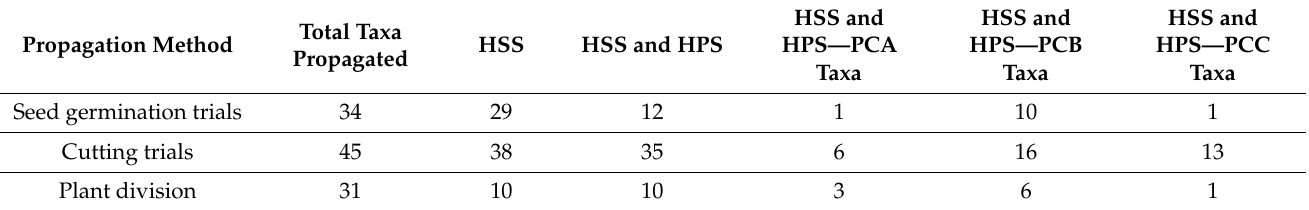
Table 4. Overview of propagation success and survival success per method employed during the ex-situ conservation of priority plants (PPs) of different categories (PCA: Threatened and Near Threatened, PCB: Local Balkan endemics and subendemics, PCC: Regionally rare and/or uncommon plants). High Survival Success (HSS): Seedling establishment rates > 75%, or rooted cuttings acclima- tization > 60%, or divided plants survival > 90%; High Propagation Success (HPS): Seed